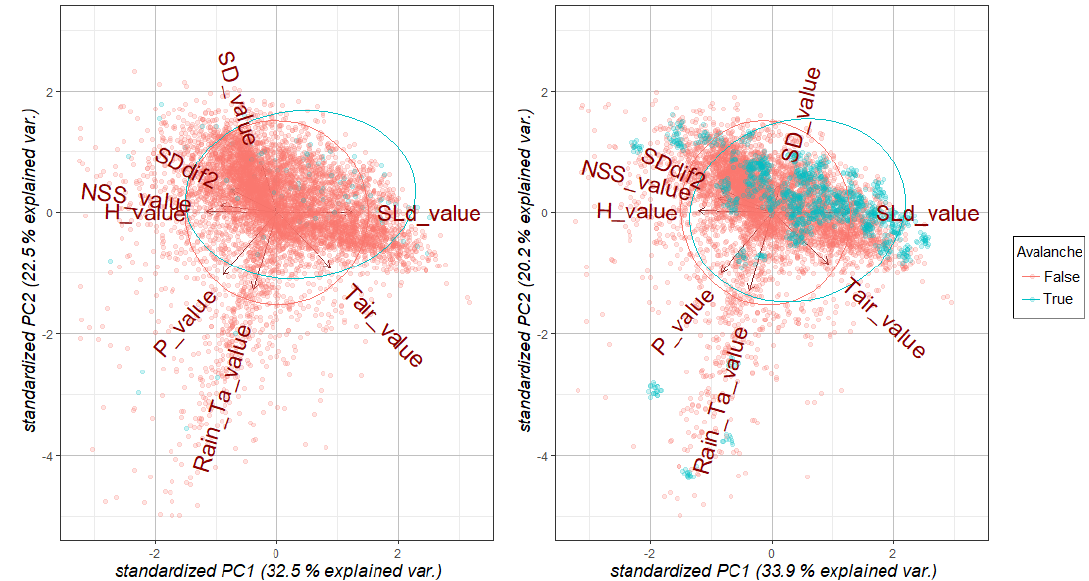
Figure A5. Comparison of original and synthetic datasets for wet avalanches using PCA.